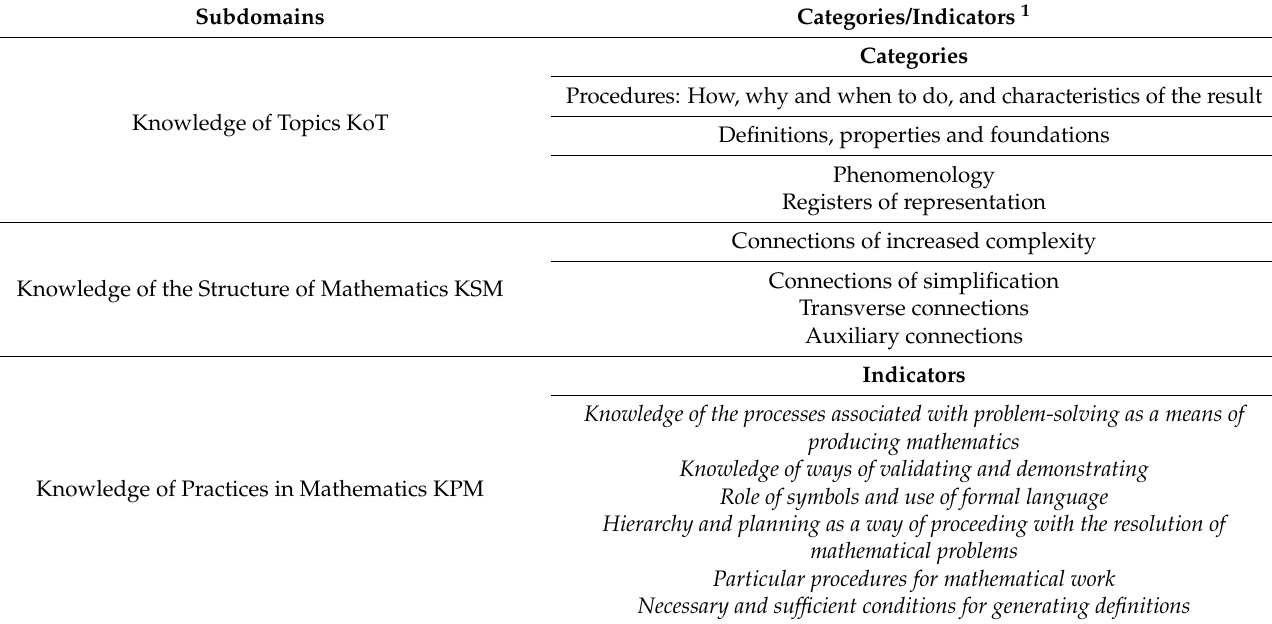
Table 1. Categories and indicators of the MK domain